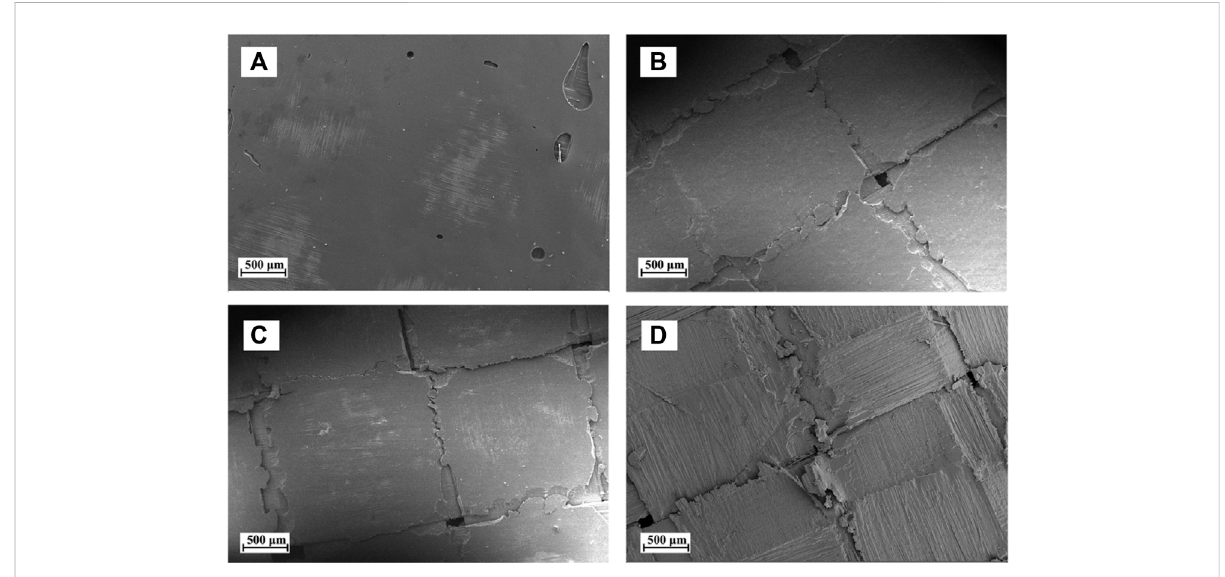
FIGURE 5 SurfacemorphologyoftheCFRPlaminatestreatedunderdifferenttemperatures: (A) originalCFRPlaminates, (B) 80 ° C, (C) 100 ° C,and (D) 140 ° C.